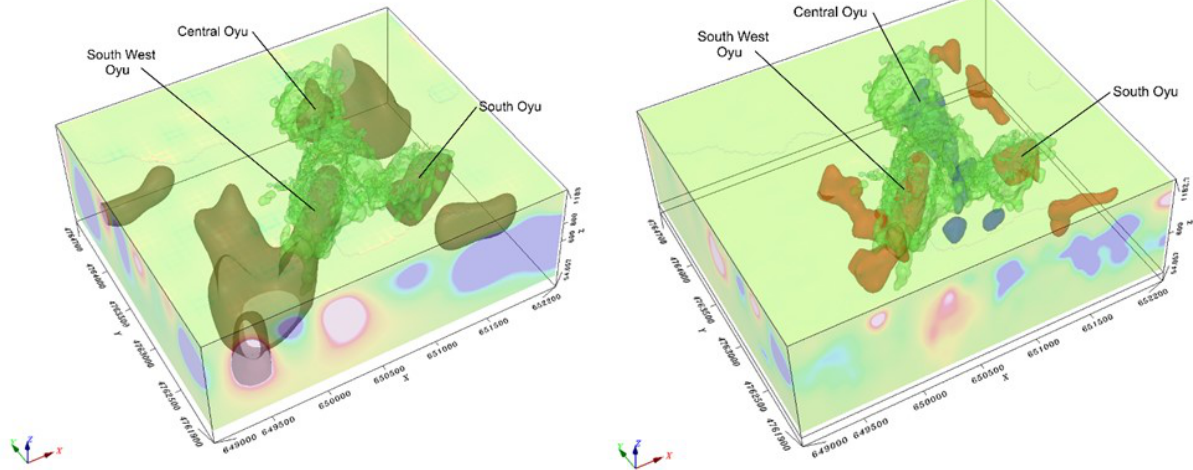
Fig. 9. The inversion results of gravity (Left) and magnetic (Right): a dark brown iso-surface inside gravity inversion is 0.05 g/cm 3 bulk density iso-surface; a brown iso-surface in magnetic inversion is 0.05 SI magnetic susceptibility iso-surface; a blue iso-surface inside magnetic inversion is - 0.06 SI magnetic susceptibility iso-surface; a green iso-surface is 0.3% copper iso-surface from core sample assay